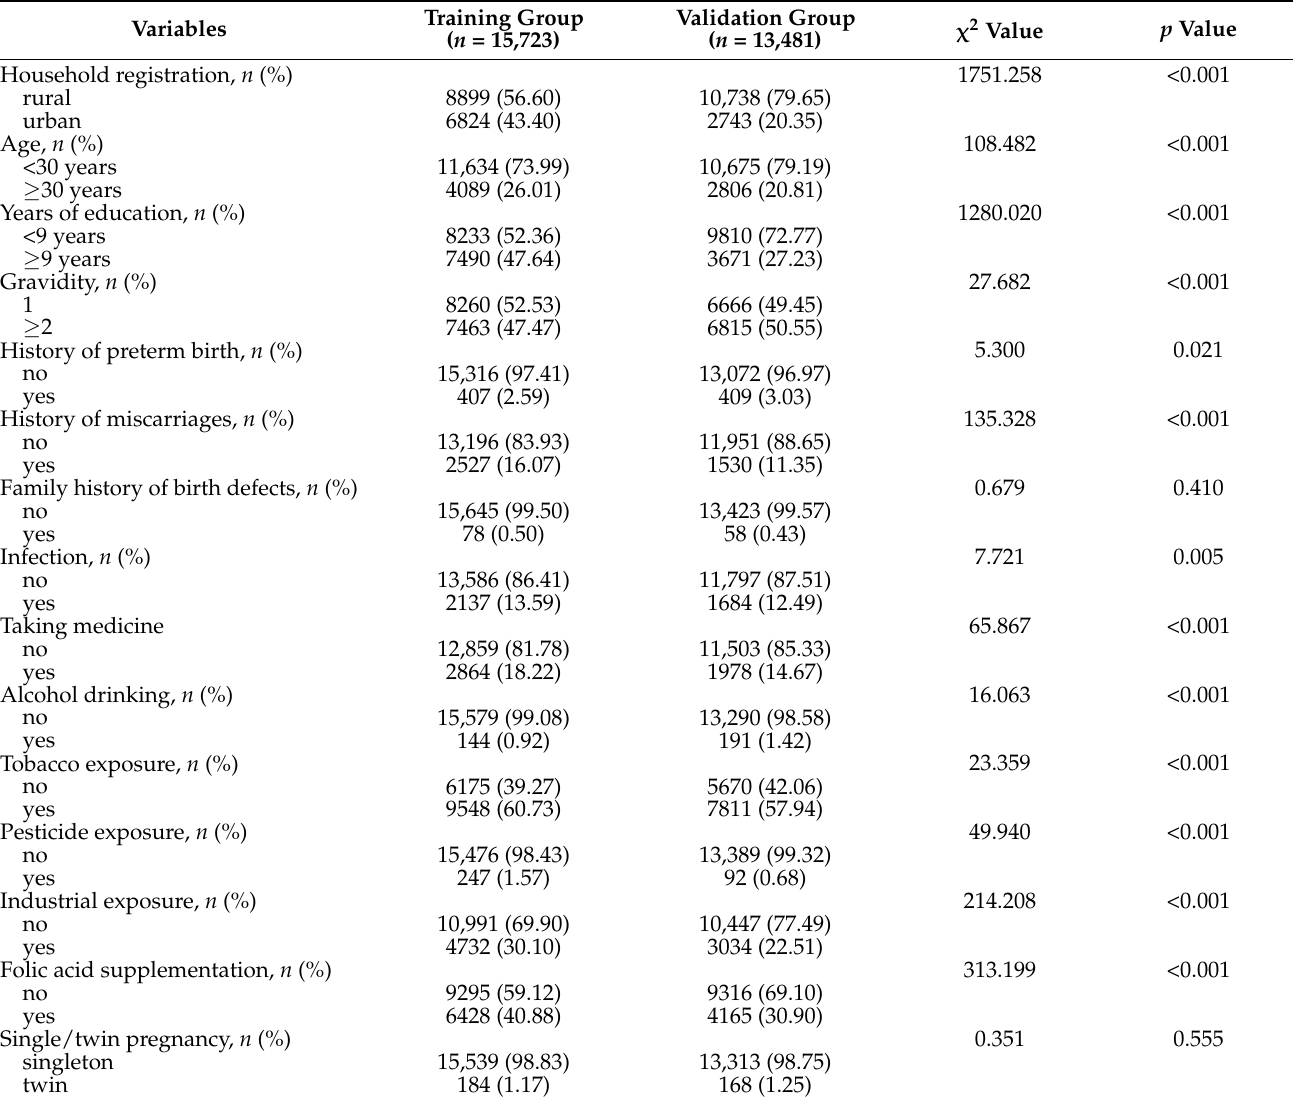
Table 1. Basic characteristics of training group and validation group